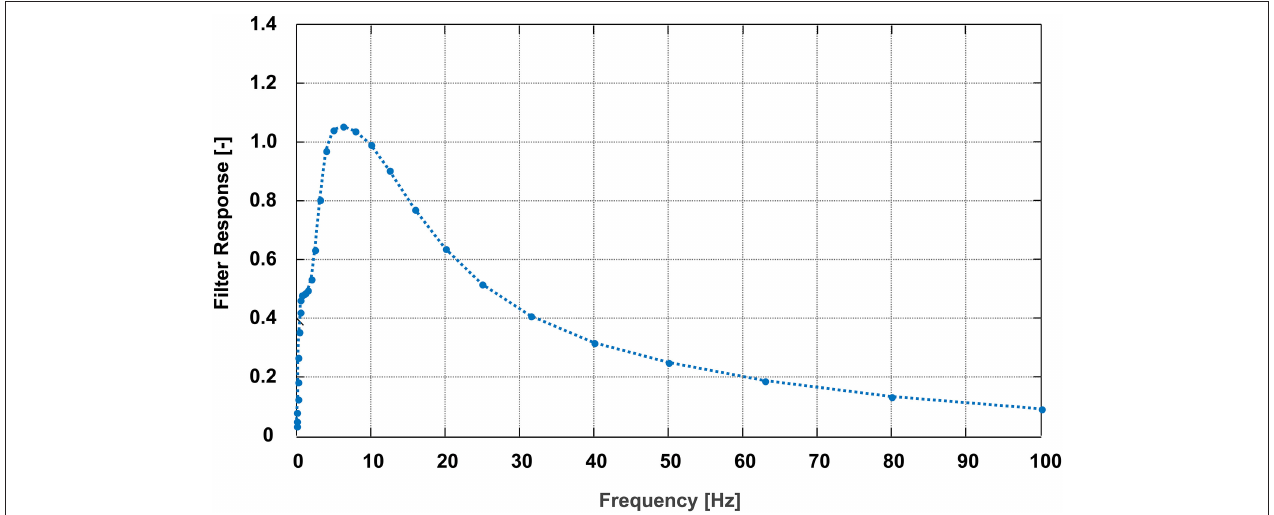
FIGURE 2 | Specifications of the frequency weighted ISO filter used for the calculation of root-mean-square acceleration in accordance with the international standard ISO 2631 ISO (1997).